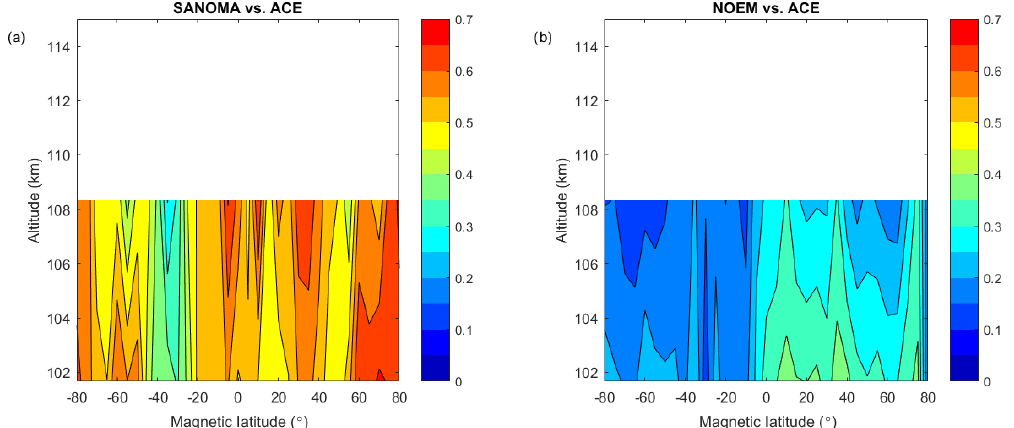
Figure 21. (a) Adjusted R 2 of a linear fit between SANOMA and ACE NO number density. (b) Adjusted R 2 of a linear fit between NOEM and ACE NO number density.